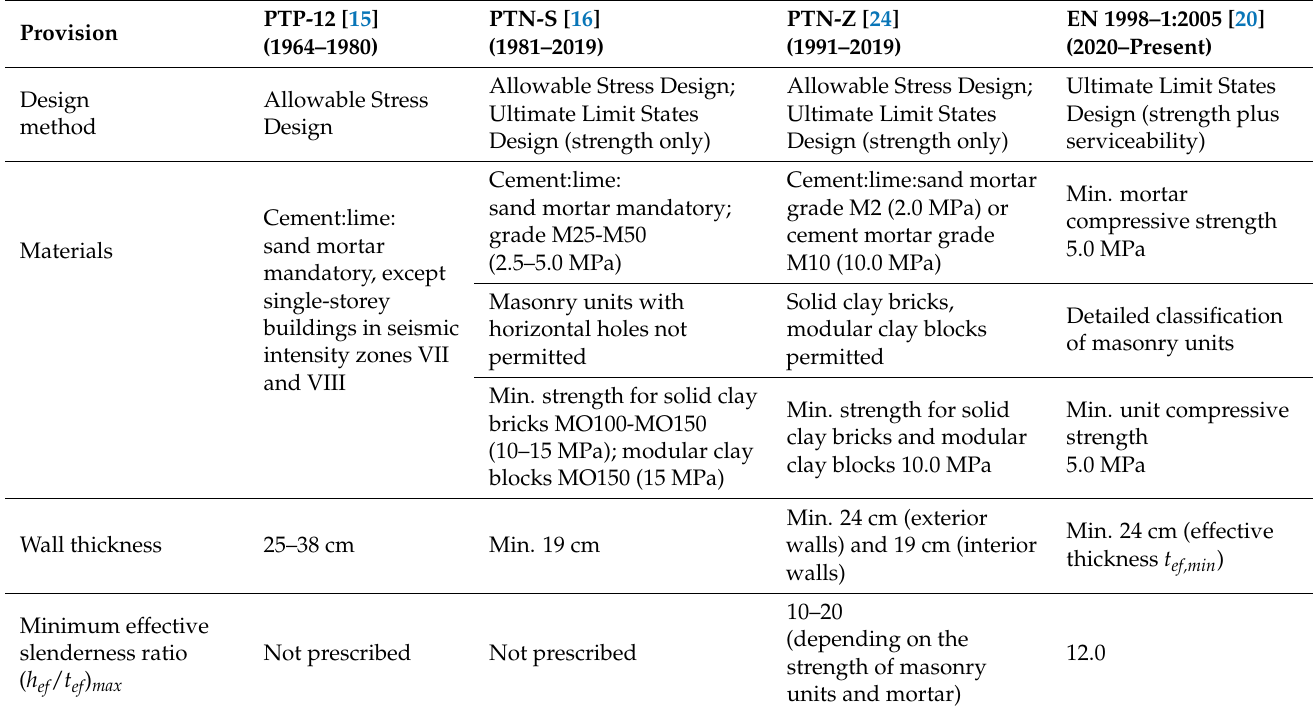
Table 3. Overview of seismic design provisions for URM (OM) buildings according to different codes (1964-present).